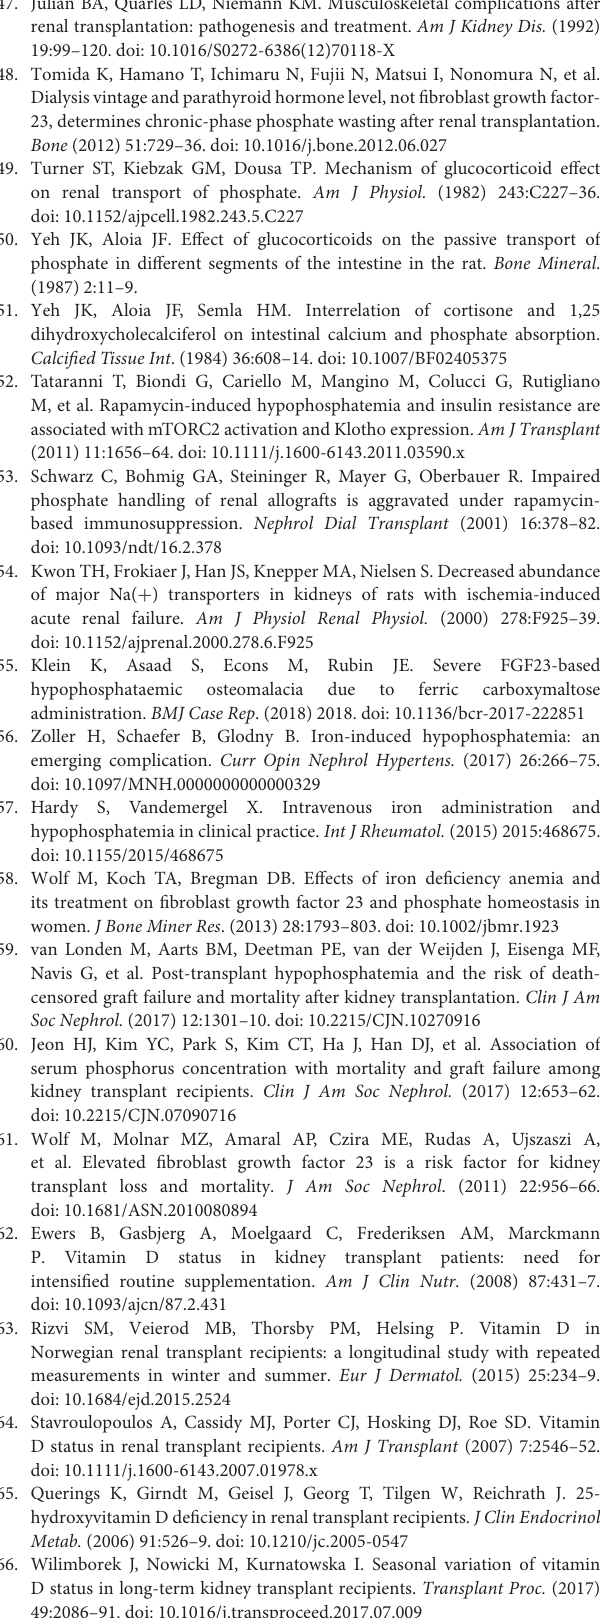
p21, p27 and vitamin D receptor in the nodular hyperplasia in patients with